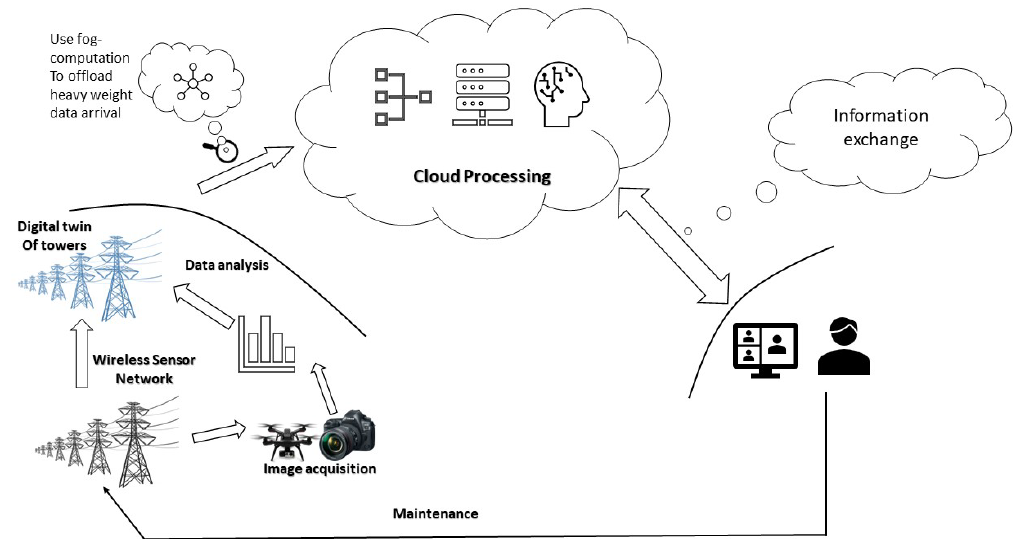
Figure 8. A model using digital twins for smart inspection of lattice towers.